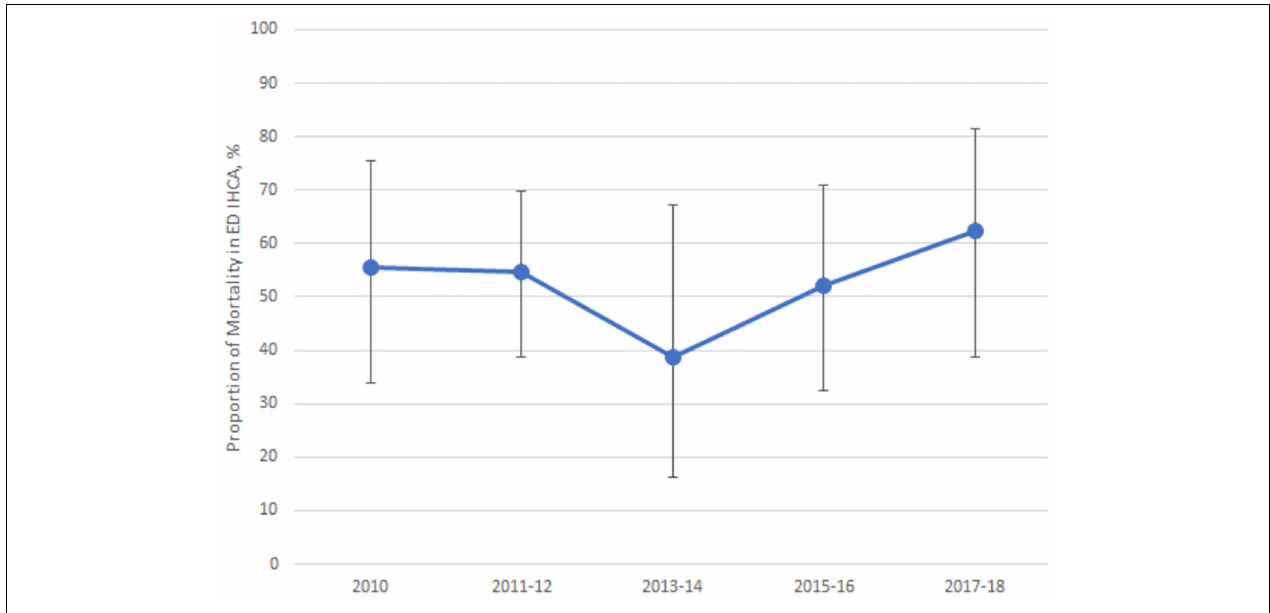
FIGURE 3 | The emergency department mortality rate of in-hospital cardiac arrest, 2010–2018.